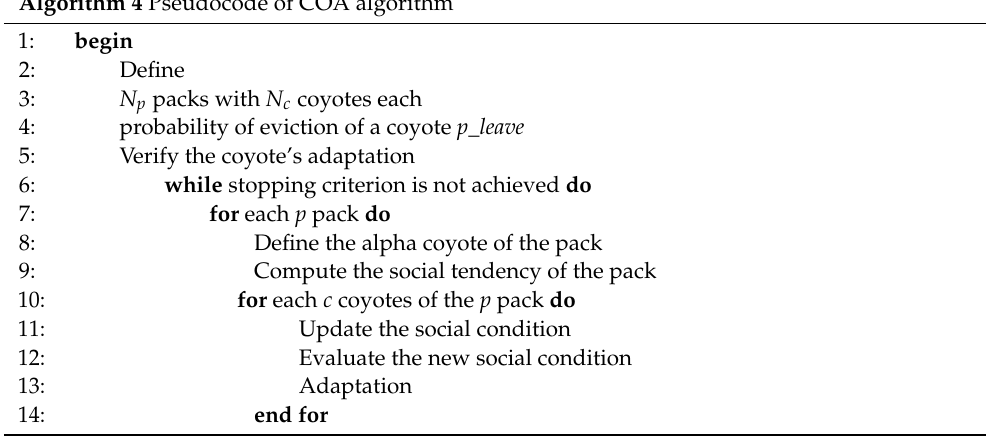
Algorithm 4 Pseudocode of COA